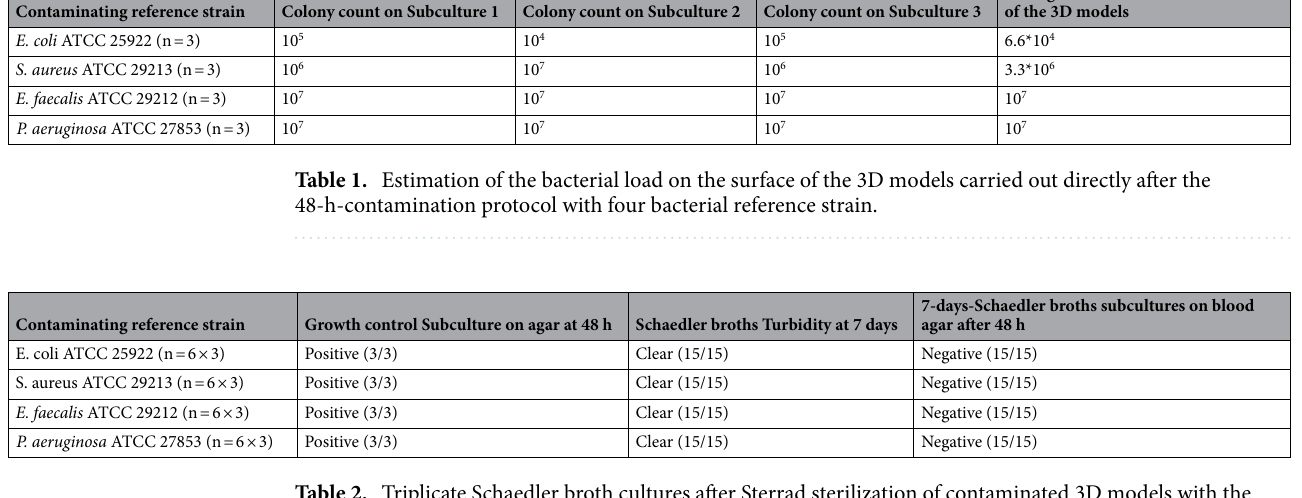
Table 2. Triplicate Schaedler broth cultures after Sterrad sterilization of contaminated 3D models with the 48-h-contamination